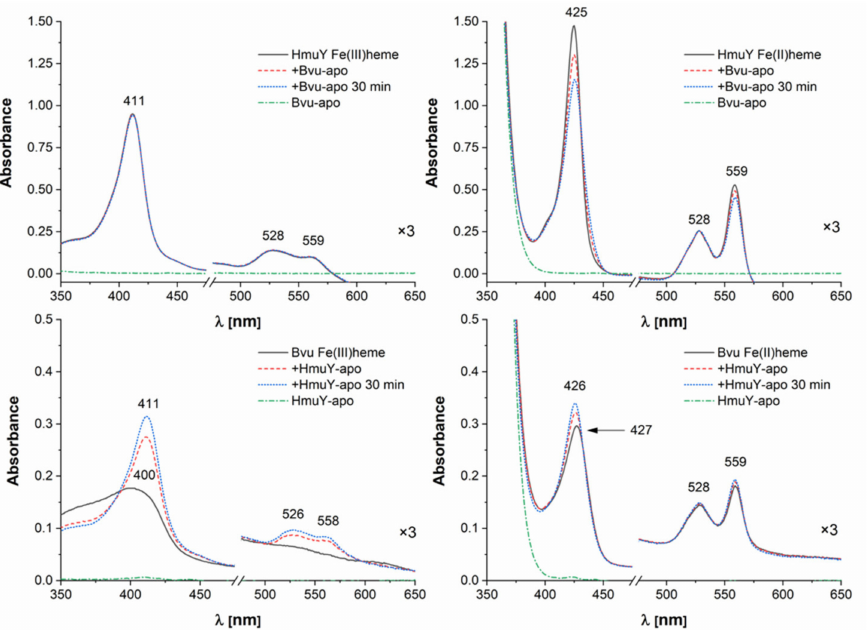
Figure 9. Heme sequestration from P. gingivalis HmuY. B. vulgatus Bvu protein was incubated with equimolar concentration of HmuY under air (oxidizing) conditions (left panel) or reducing conditions formed by addition of sodium dithionite (right panel). Changes in absorption spectra analyzed by UV-visible spectroscopy are shown at indicated